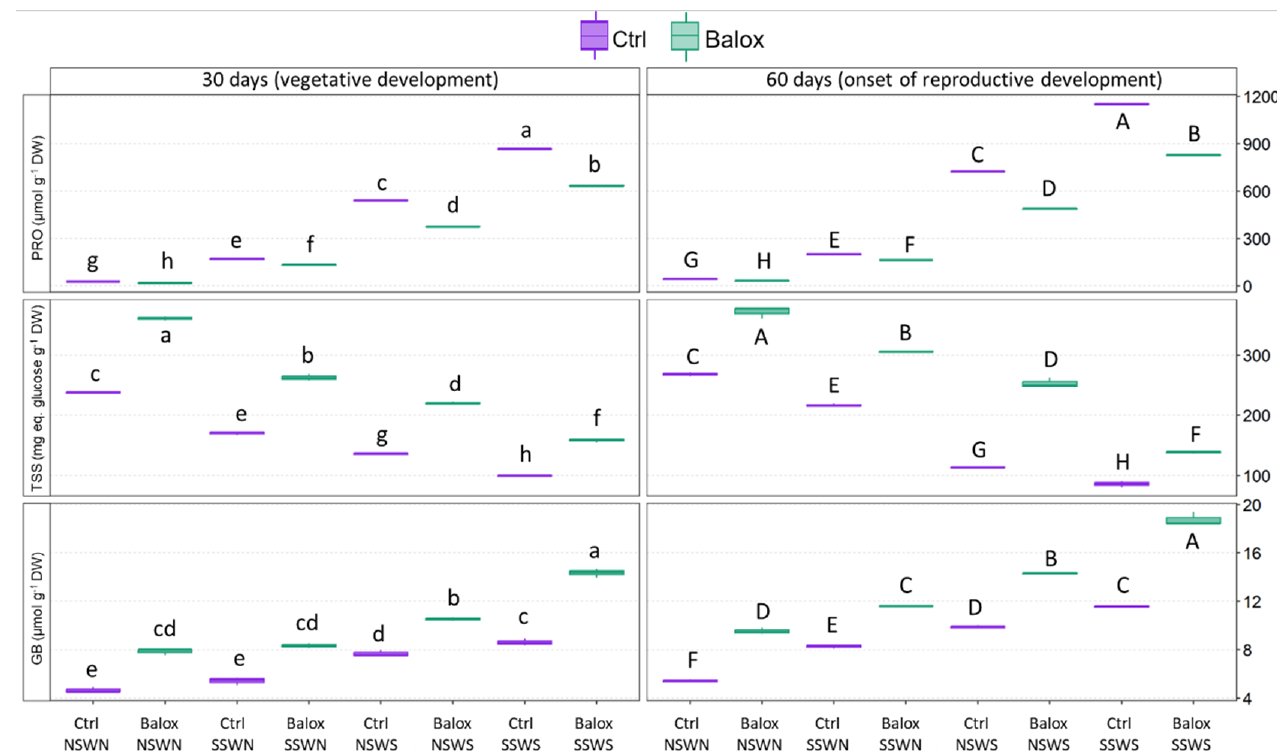
Figure 8. Proline (PRO), glycine betaine (GB), and total soluble sugars (TSS) content in leaves of tomato plants subjected to increasing salinity by different combinations of saline or non-saline soil and irrigation water; the plants were treated, or not, with the biostimulant containing polyphenols at 1.4% ( w / w ) and glycine betaine at 3.0% ( w / w ) at a dose of 0.4 mL L − 1 of irrigation water. The control treatments without biostimulant (Ctrl) and with biostimulant (BALOX ® ) are defined as follows: (i) NSWN: Non-saline soil (EC = 2.28 dS/m) and non-saline water (EC = 0.91 dS/m); (ii) SSWN: Saline soil (EC = 8.55 dS/m) and non-saline water (EC = 0.91 dS/m); (iii) NSWS: Non-saline soil (EC = 2.28 dS/m) and saline water (EC = 10.50 dS/m); (iv) SSWS: Saline soil (EC = 8.55 dS/m) and saline water (EC = 10.50 dS/m). The evaluation periods: 30 days and 60 days of treatments. The values are the means ± SE ( n = 3). Different letters above the bars (lowercase for 30 days and capital for 60 days of treatments) indicate significant differences between treatments, according to the ANOVA test ( p < 0.05). Statistical analyses were performed independently for the two treatment periods.